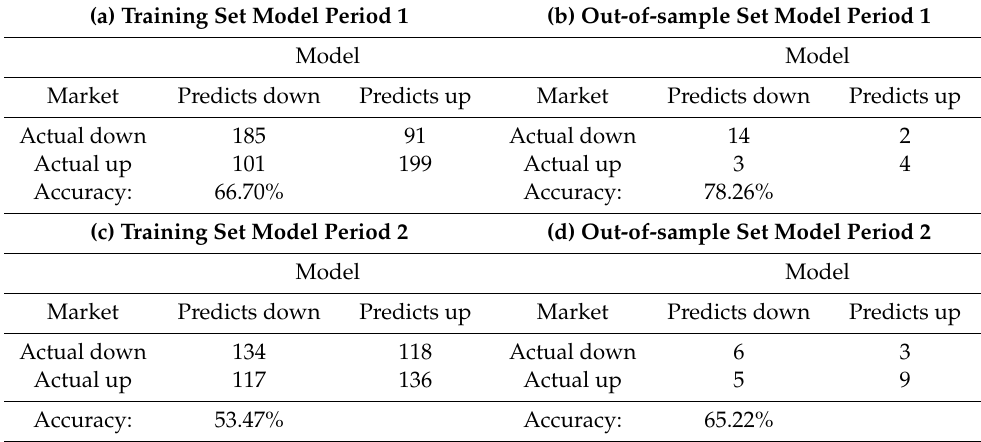
Table 3. Confusion matrices of the models for the two periods: (a,c) training sets, (b,d) out-of-sample sets. Positive class down.